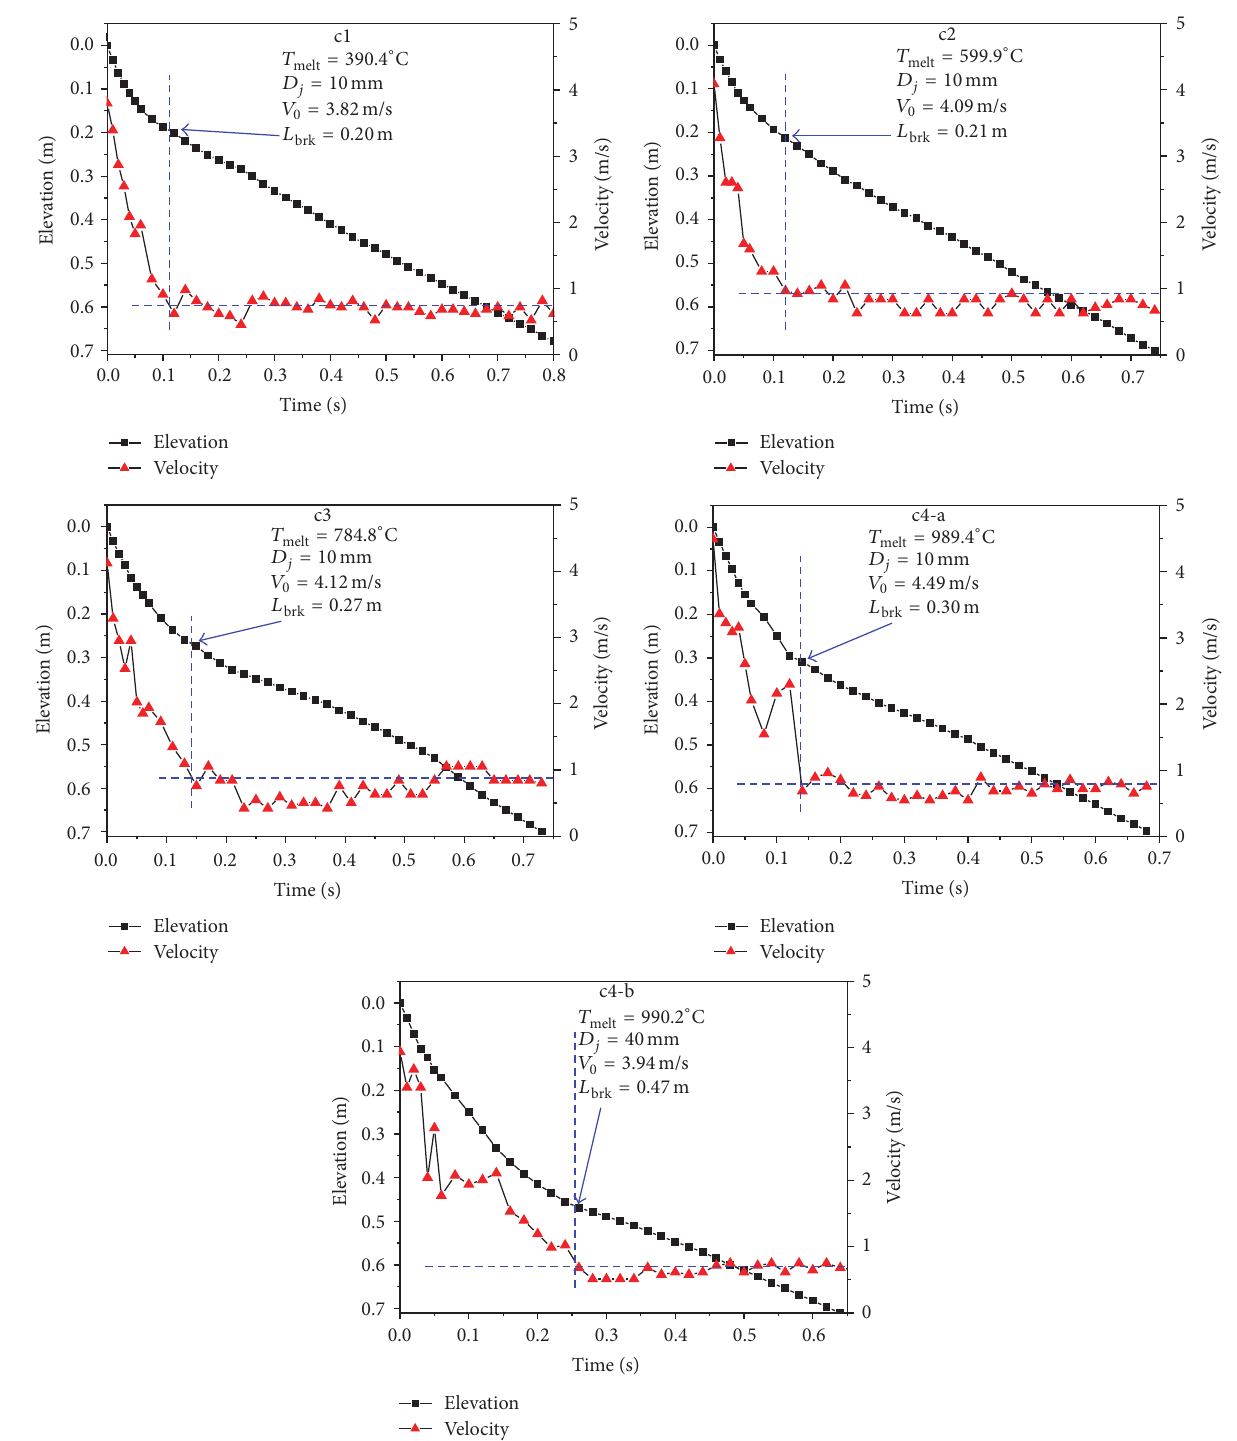
Figure 6: The elevation of jet front and injection